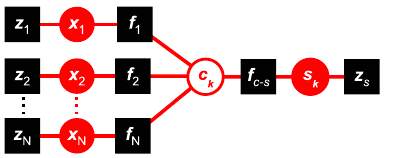
Table 1: Salinas hyperspectral benchmark classes (available ground truth samples)